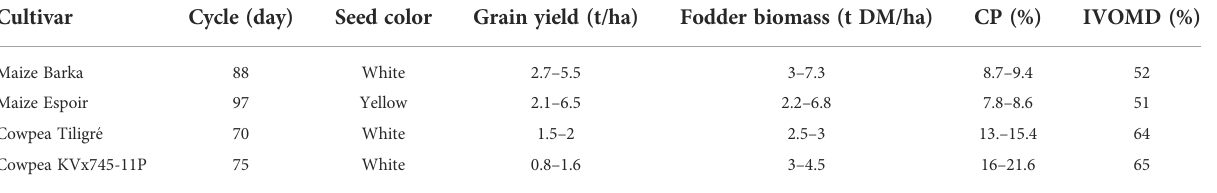
Maize Barka 88 Maize Espoir 97 Cowpea Tiligre ́ Cowpea